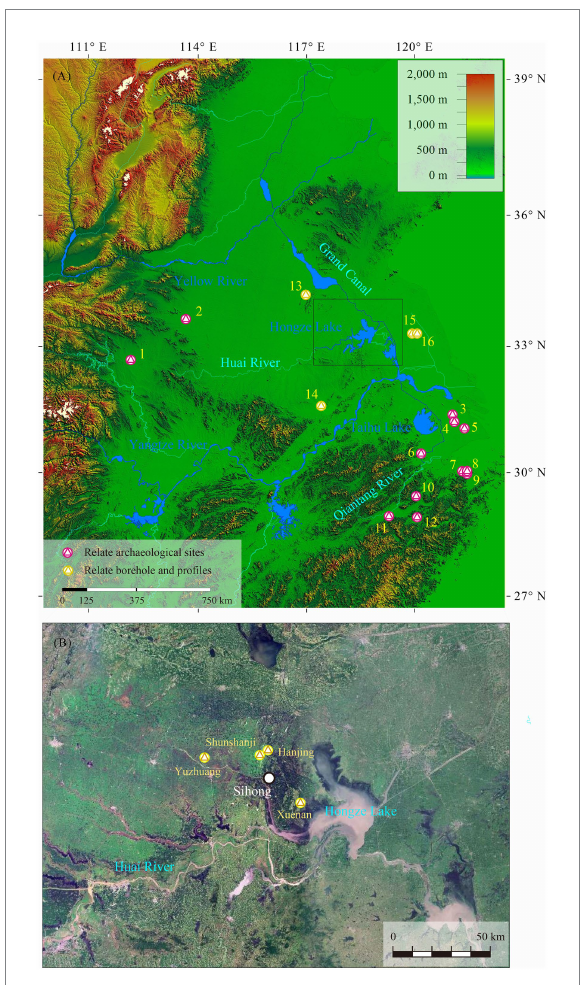
FIGURE 1 Study area (A) and an enlarged view of the distribution area of the Shunshanji cultural site group (B) . 1. Baligang site; 2. Jiahu site; 3. Zhumucun site; 4. Jiangli site; 5. Guangfulin site; 6. Maoshan site; 7. Shi’ao site; 8. Tianluoshan site; 9. Hemudu site; 10. Shangshan site; 11. Hehuashan site; 12. Huxi site; 13. Huangkou borehole; 14. Chao Lake borehole; 15. Sanchakou profile; 16. Qingfeng